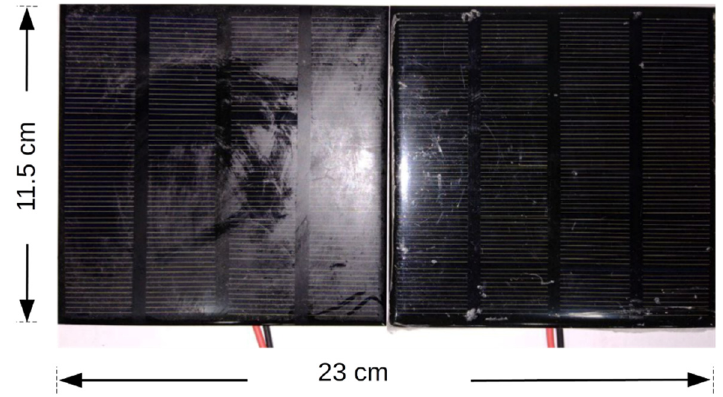
Figure 8. The internal structure of a silicon solar cell.